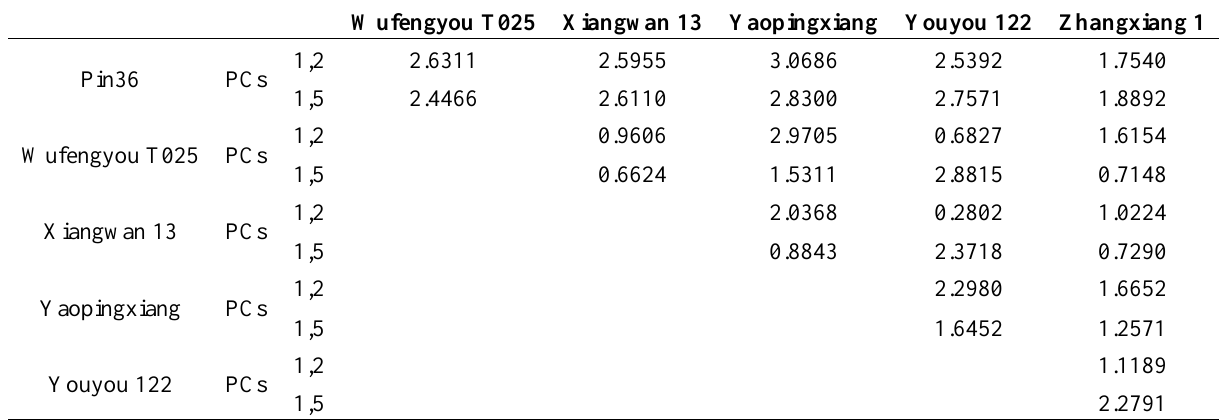
Table 2. MDs of the centre points of the sample data points for the six rough rice